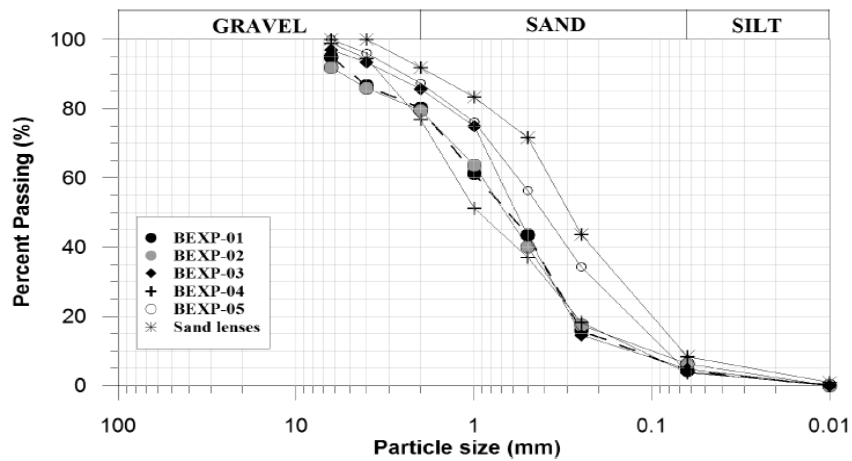
Figure 3. Grain-size distribution curves for aquifers in the study area.